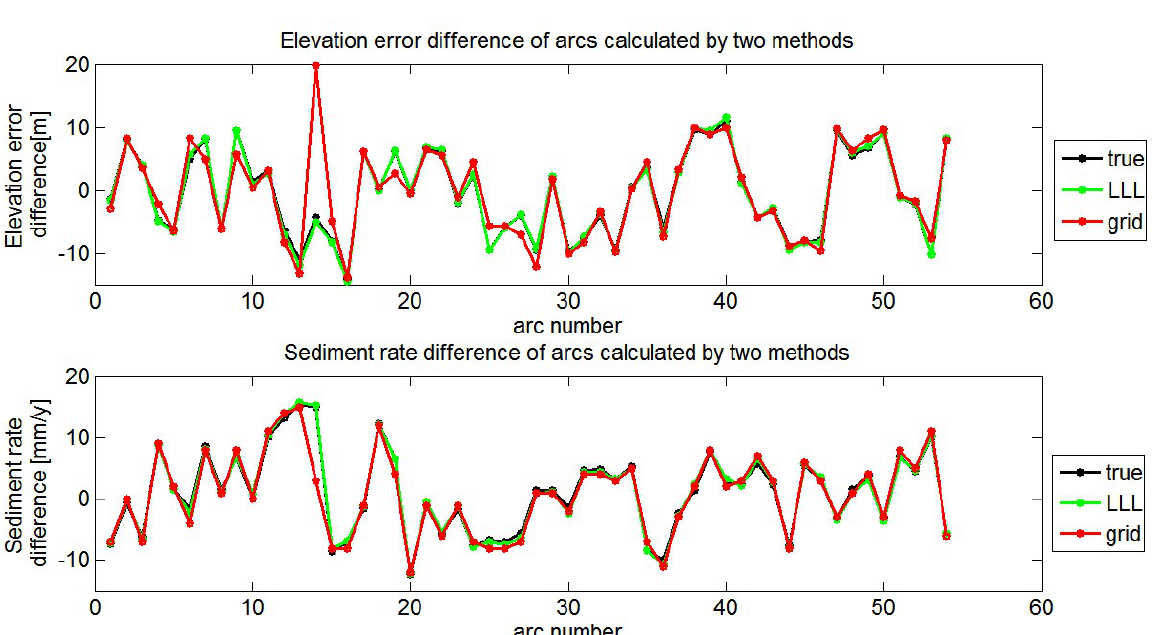
Table 1. The basic parameters in simulation Figure 8 shows the elevation difference and sediment rate difference of all PSPs calculated by the LLL algorithm and the Overview of parameters: grid search method. Figure 9 shows the absolute elevation and sediment rate of PS points calculated by the two methods with respect to the last PS point. (Assume that the absolute elevation and sediment rate of 20th point are zero.) Table 2 shows the comparison of true relative elevation errors and sediment rate differences of 54 PSPs and their corresponding solutions.